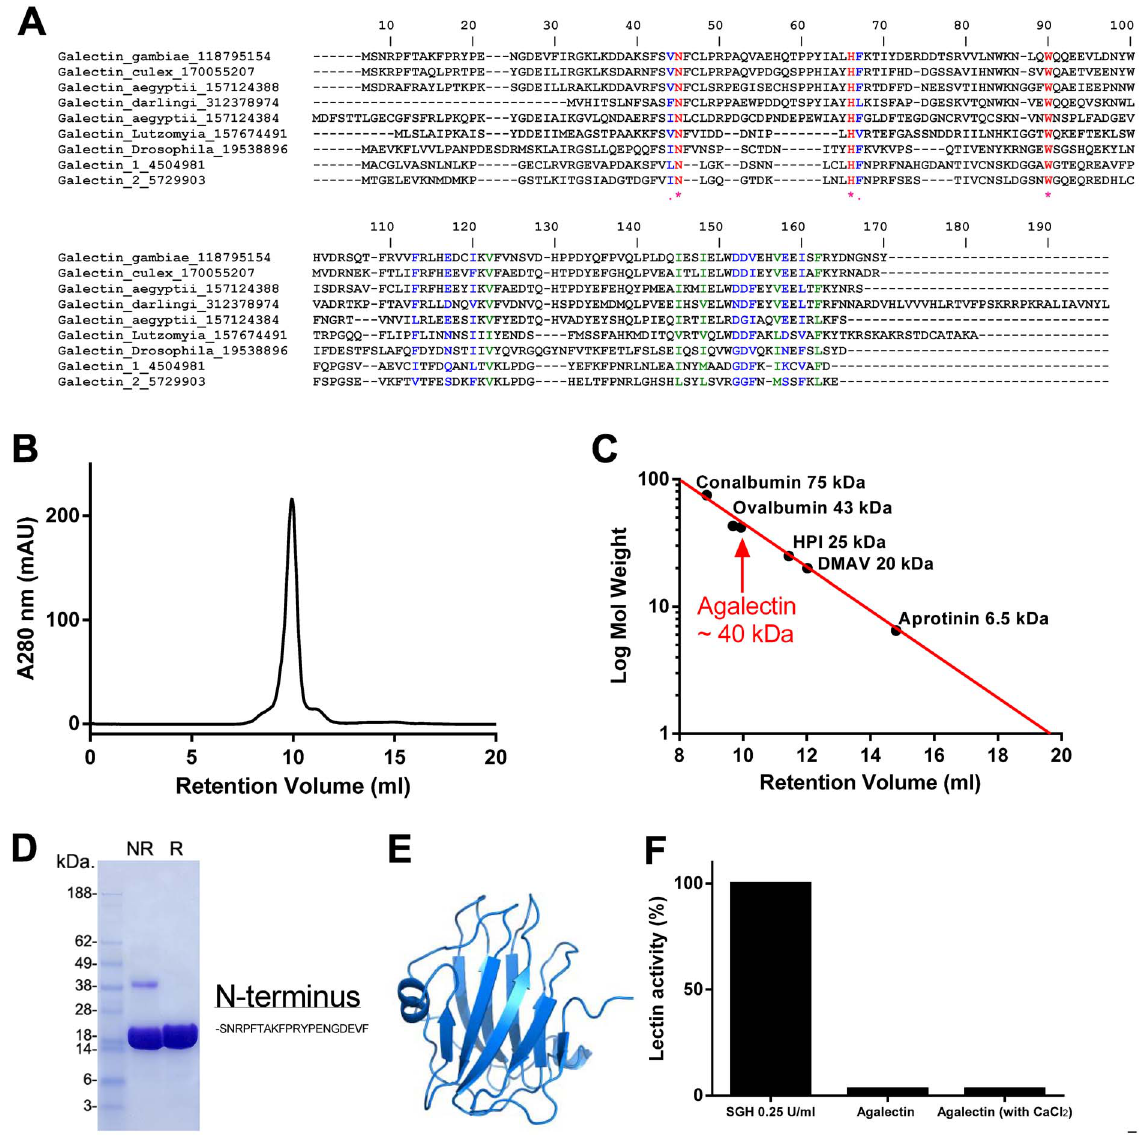
Figure 3. Expression of Agalectin, a member of the galectin family of lectin. (A) Clustal aligment of Agalectin with orthologs from Diptera, human galectin-1 and galectin-2. (B) Galectin purification. The chromatogram of the last purification step is shown. (C) SDS-PAGE of Agalectin, under reducing, or denaturing conditions. (D) Molecular weight determination. The retention volume of Agalectin was compared with molecular weight markers, and determined to behave as a dimer in solution. (E) Molecular modeling of Agalectin. Based on the galectin domain of porcine adenovirus (PDB 2WSU). (F) Lectin activity. Agalectin does not agglutinate RBC, with or without CaCl 2 (n=3).